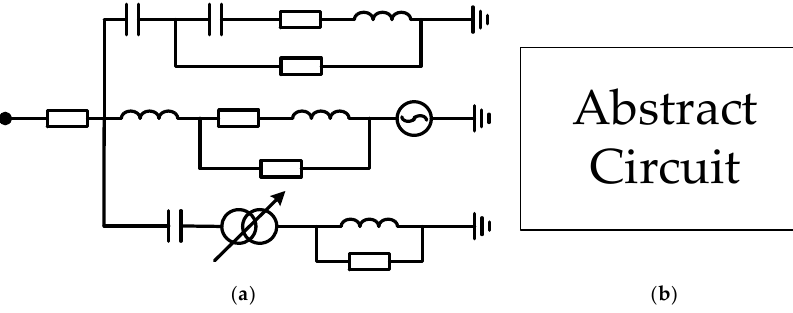
Figure 6. The circuit used to increase node of network: ( a ) actual circuit; and ( b ) abstract circuit.